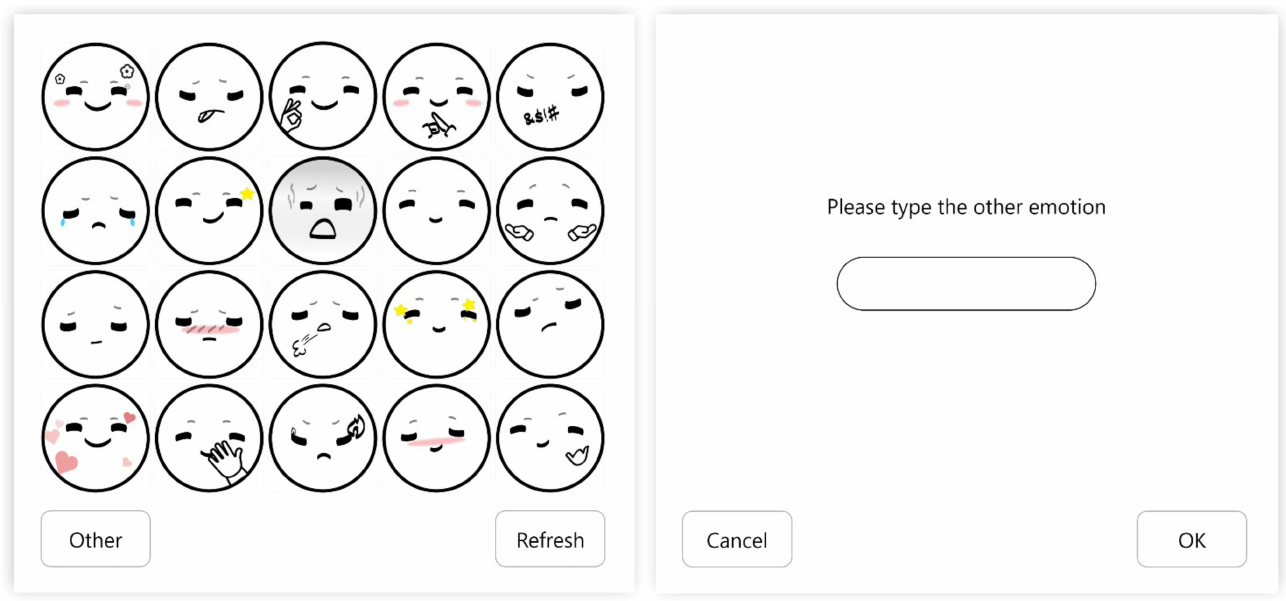
Figure 4. Screenshot of SAET